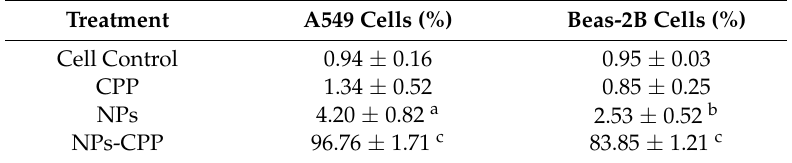
Means ( n =3 ± StDev) of each cell line were statistically analysed by one-way ANOVA and compared each treatment with cell control using Tukey’s test. Superscript letter indicates statistical difference: a P < 0.05; b P < 0.01; c P < 0.0001. NPs and NPs–CPP were labelled with Rhodamine B at 0.1% of polymer weight.